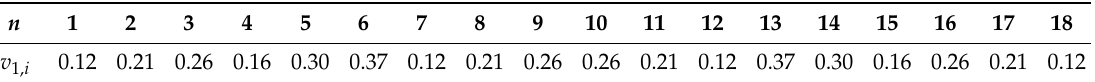
Figure 5. Fiedler eigenvector coordinates for the layout A, B, C, and D. Table 2. Eigenvector centrality for all the nodes in Example Network, layout D.